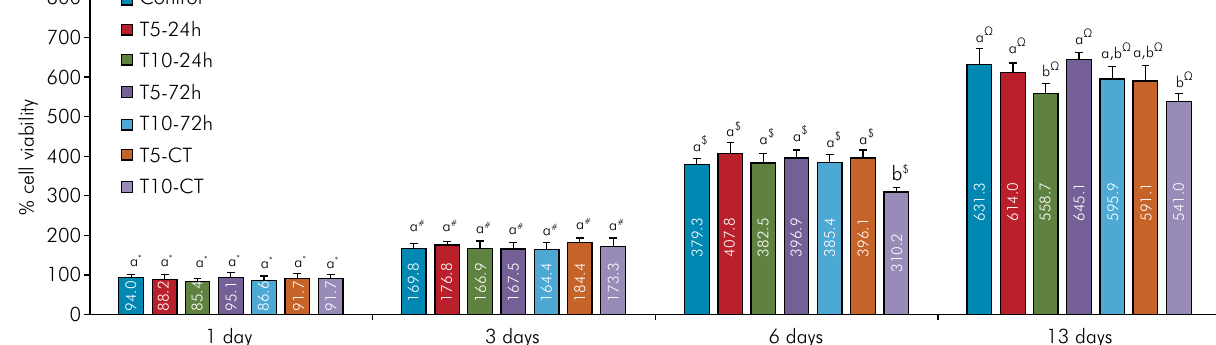
Figure 2. Cell viability (mean/standard deviations) at the time points of 1, 3, 6, and 13 days of treatments with different concentrations of taxifolin (5 and 10 µM) for 24h, 72h and continuous treatment (CT), using MTT assays. Control: DMEM with 10 µM DMSO.